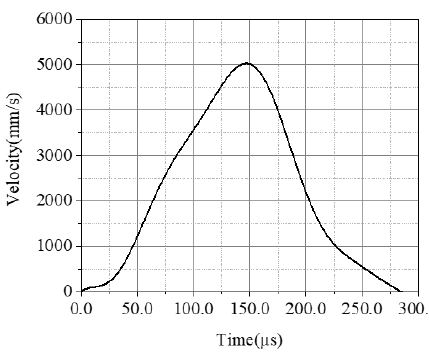
Figure 3. The boundary particle velocity at the loading end of concrete bar.